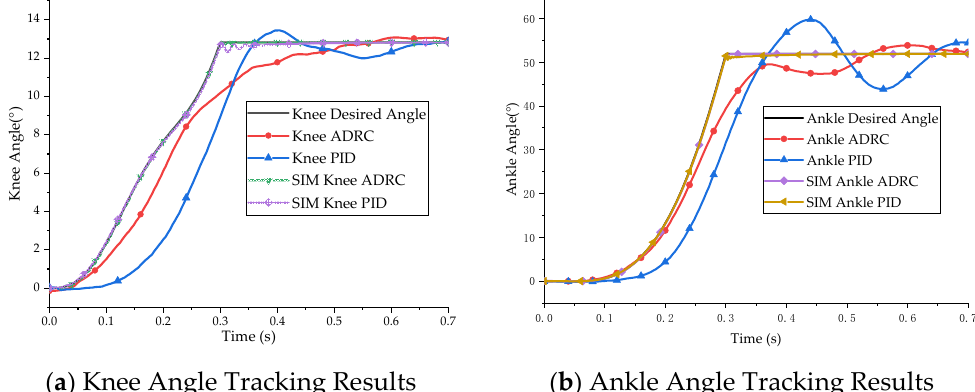
Figure 10. Experimental results of bionic leg joint angle control.